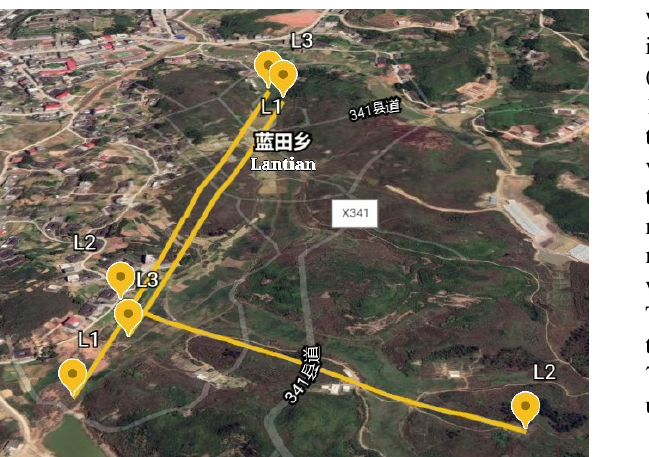
Figure 13. Schematic layout of the survey lines. (The 75th mea- surement point on the L1 survey line intersects with the 59th mea- surement point on the L2 survey line, and the 72nd measurement point on the L3 survey line intersects with the 57th measurement point on the L2 survey line.) (© Gaode Map, 2021.)